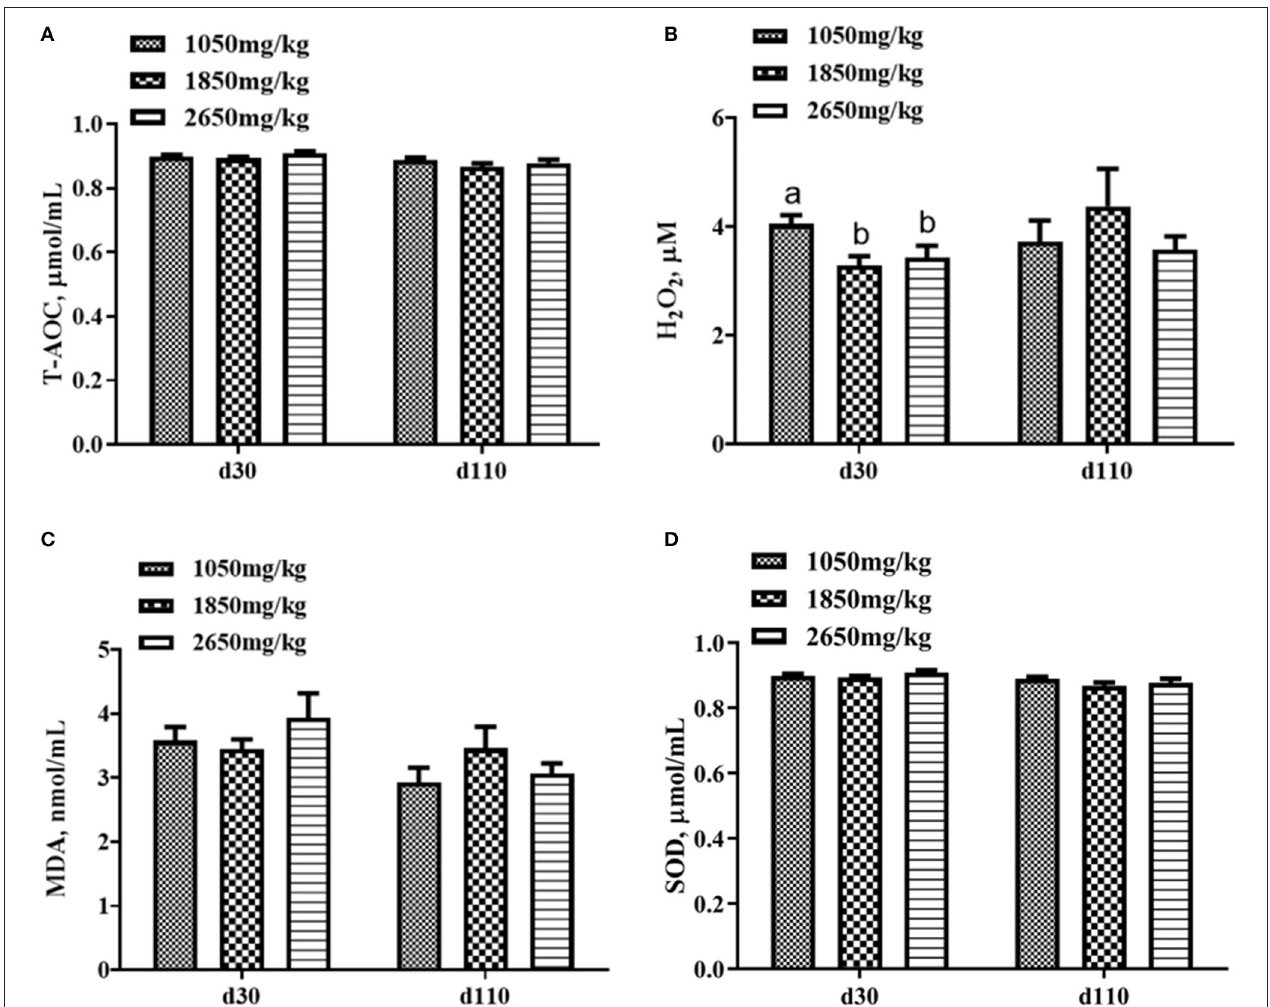
FIGURE 2 | Effect of dietary choline levels during gestation on the plasma concentrations of T-AOC (A) H 2 O 2 , (B) MDA, (C) SOD, and (D) at days 30 and 110 of gestation. Data are expressed as mean values with their standard errors, N = 8 for each treatment. a, b Mean values with unlike letters were significantly different ( P < 0.05).